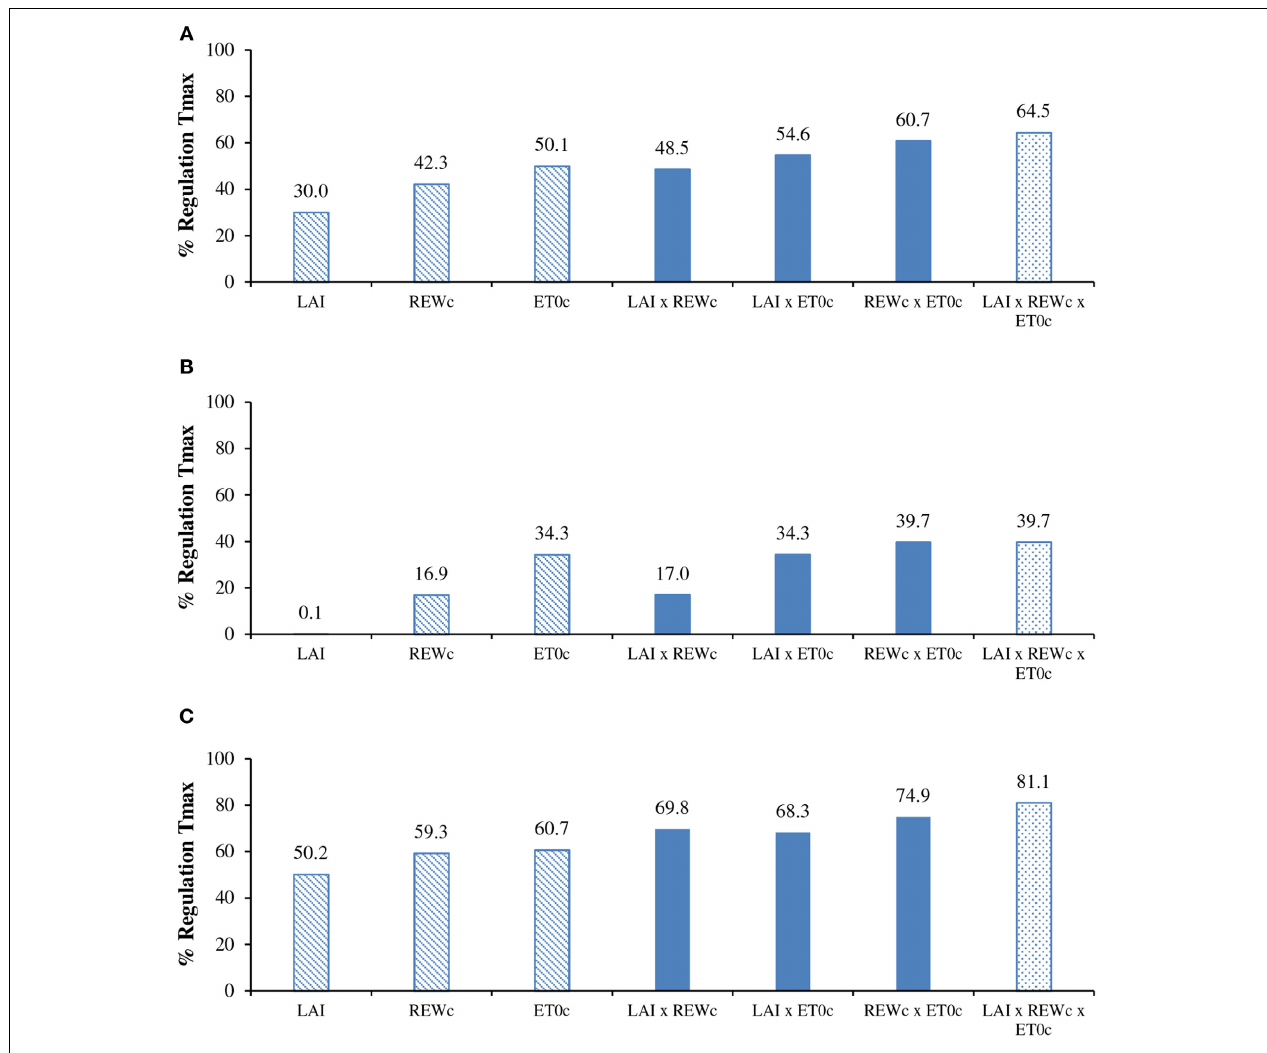
FIGURE 6 | Regulation of seasonal transpiration (simulated with constraints/maxima) for: (A) the annual cycle; (B) the rainy season; and (C) the dry season, according to reduction factors issued from the LAI